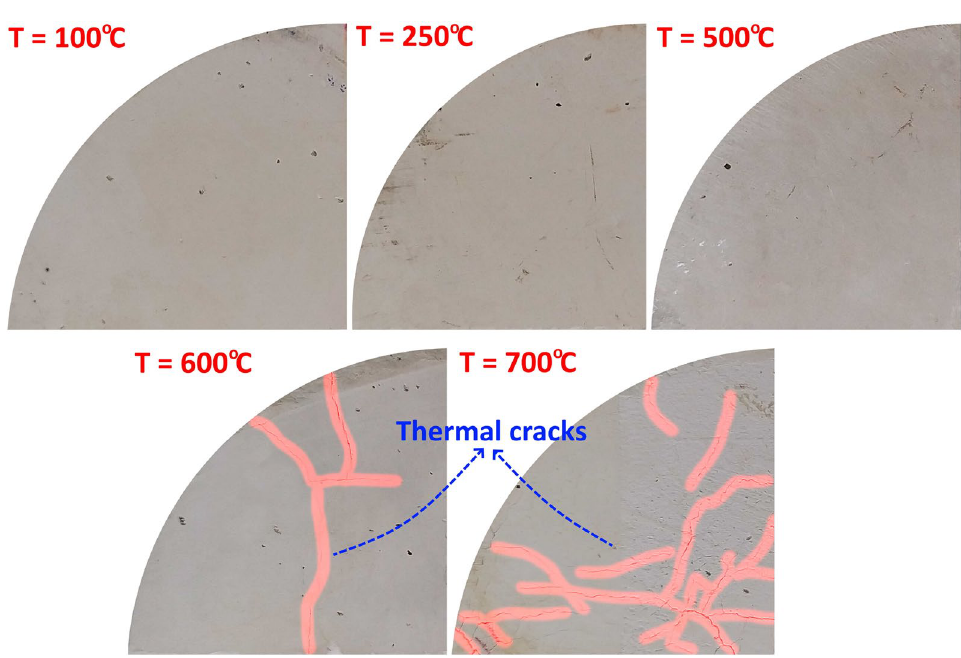
Figure 12. Monitor the growth of thermal cracks after thermal treatment at temperatures of 100, 250, 500, 600 and 700